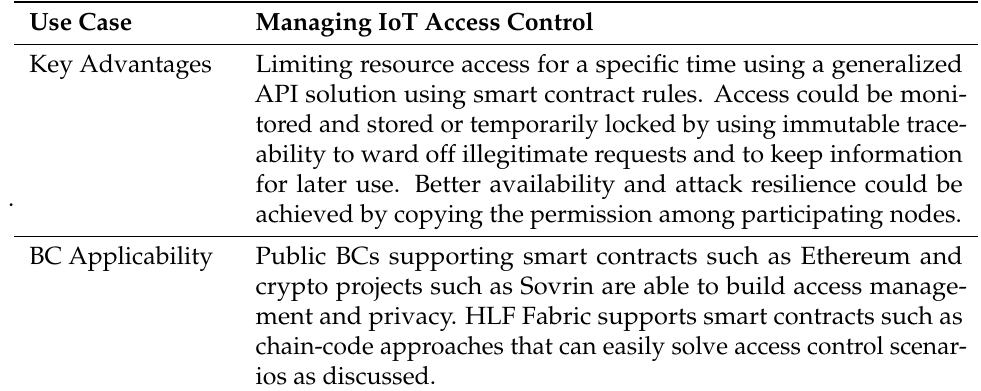
Table 5. Key advantages and BC applicability for the IoT access control use case